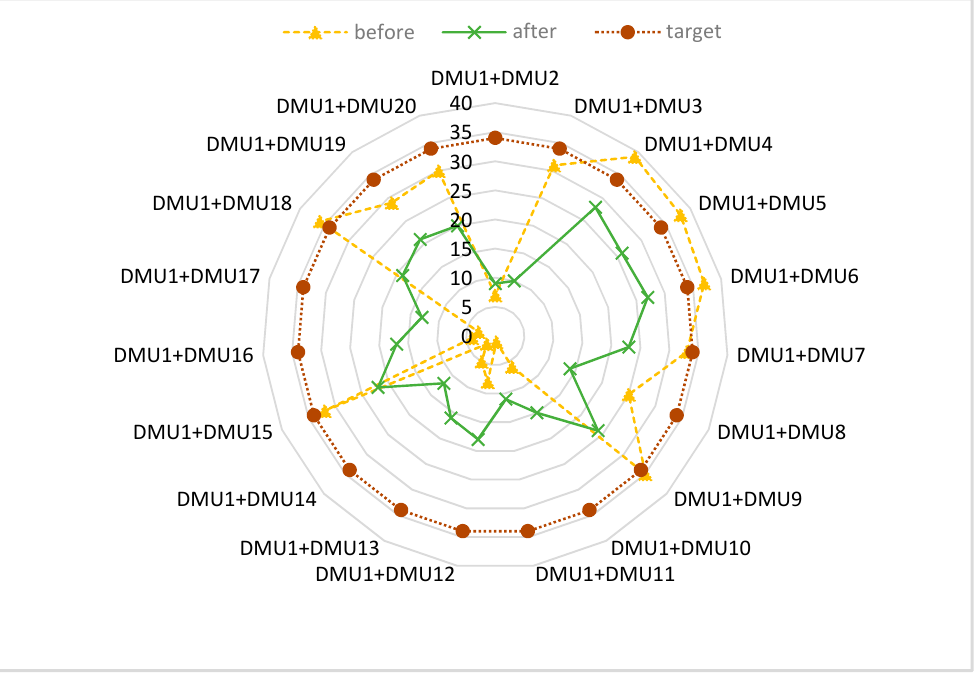
Figure 3. Radar comparison chart.